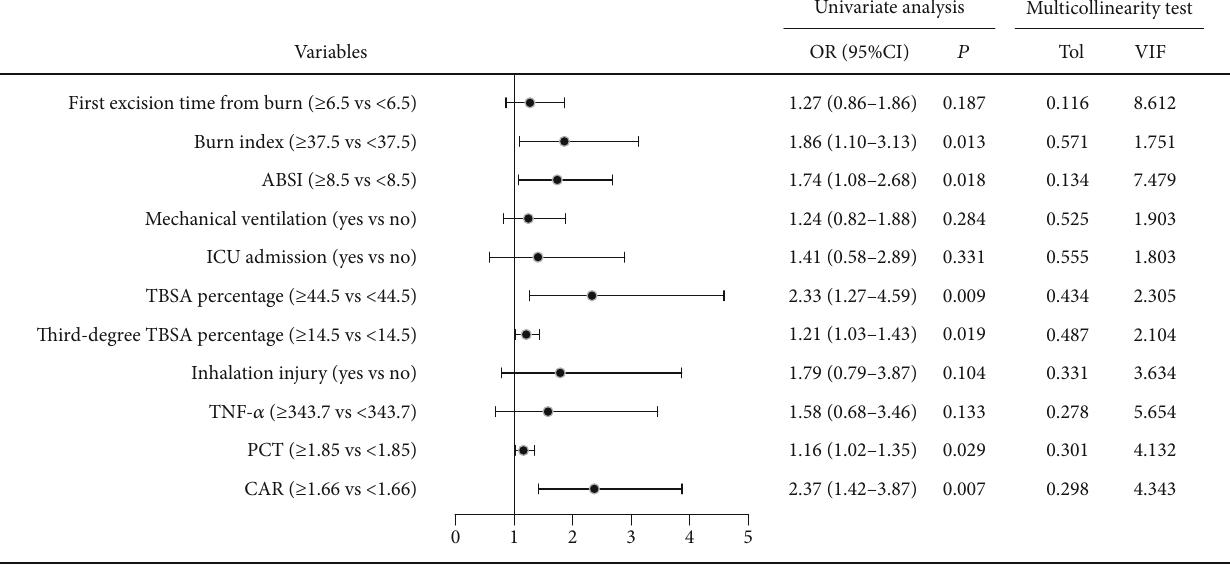
Figure 3: Forest plot of risk factors for sepsis by the univariate logistic regression analysis and multicollinearity test. ABSI: abbreviated burn severity index; TBSA: total burn surface area; ICU: intensive care unit; PCT: procalcitonin; TNF- α : tumor necrosis factor- α ; CAR: C-reactive protein-to-albumin ratio; OR: odds ratio; CI: con fi dence interval; Tol: tolerance; VIF: variance in fl ation factor.